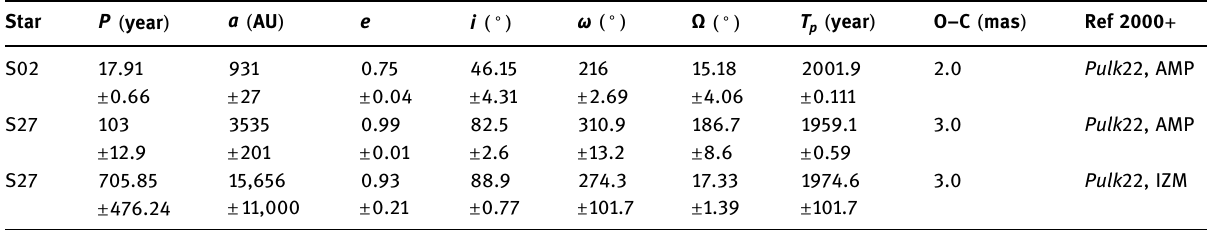
Table 2: Orbital elements of S - cluster stars obtained by di ff erent methods